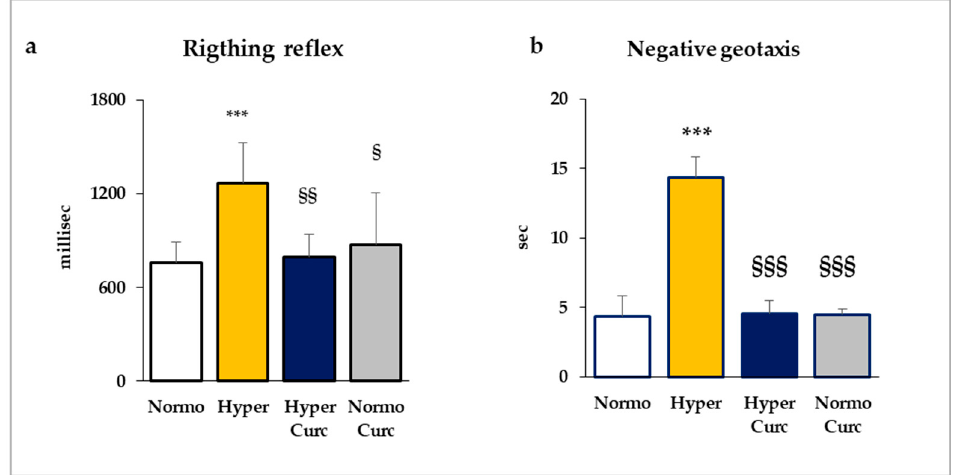
Figure 3. Curc restores the motor abilities of Hyper Gunn rats. The righting reflex ( a ) and the negative geotaxis ( b ) were selected as optimal tests for assessing the motor and coordination abilities of Gun rat pups. With white bars—untreated normobilirubinemic (Normo) Gunn pups; yellow bars—untreated hyperbilirubinemic rats (Hyper); blue bars—curcumin-treated hyperbilirubinemic pups (Hyper Curc); gray bars—curcumin-treated normobilirubinemic pups (Normo Curc). Data are in mean ± S.D., and in milliseconds (millisec) for the righting reflex and in seconds (sec) in the negative geotaxis test. In each experimental group, ≥ 3 animals were studied. Statistical significance was evaluated by the one-way analysis of variance (ANOVA), followed by a Tukey–Kramer Multiple Comparisons Test when p -value < 0.05. Statistical significance: ***: p < 0.001 vs. Normo pups. §; §§, §§§: p < 0.05, p < 0.01, p < 0.001 vs. Hyper rats.